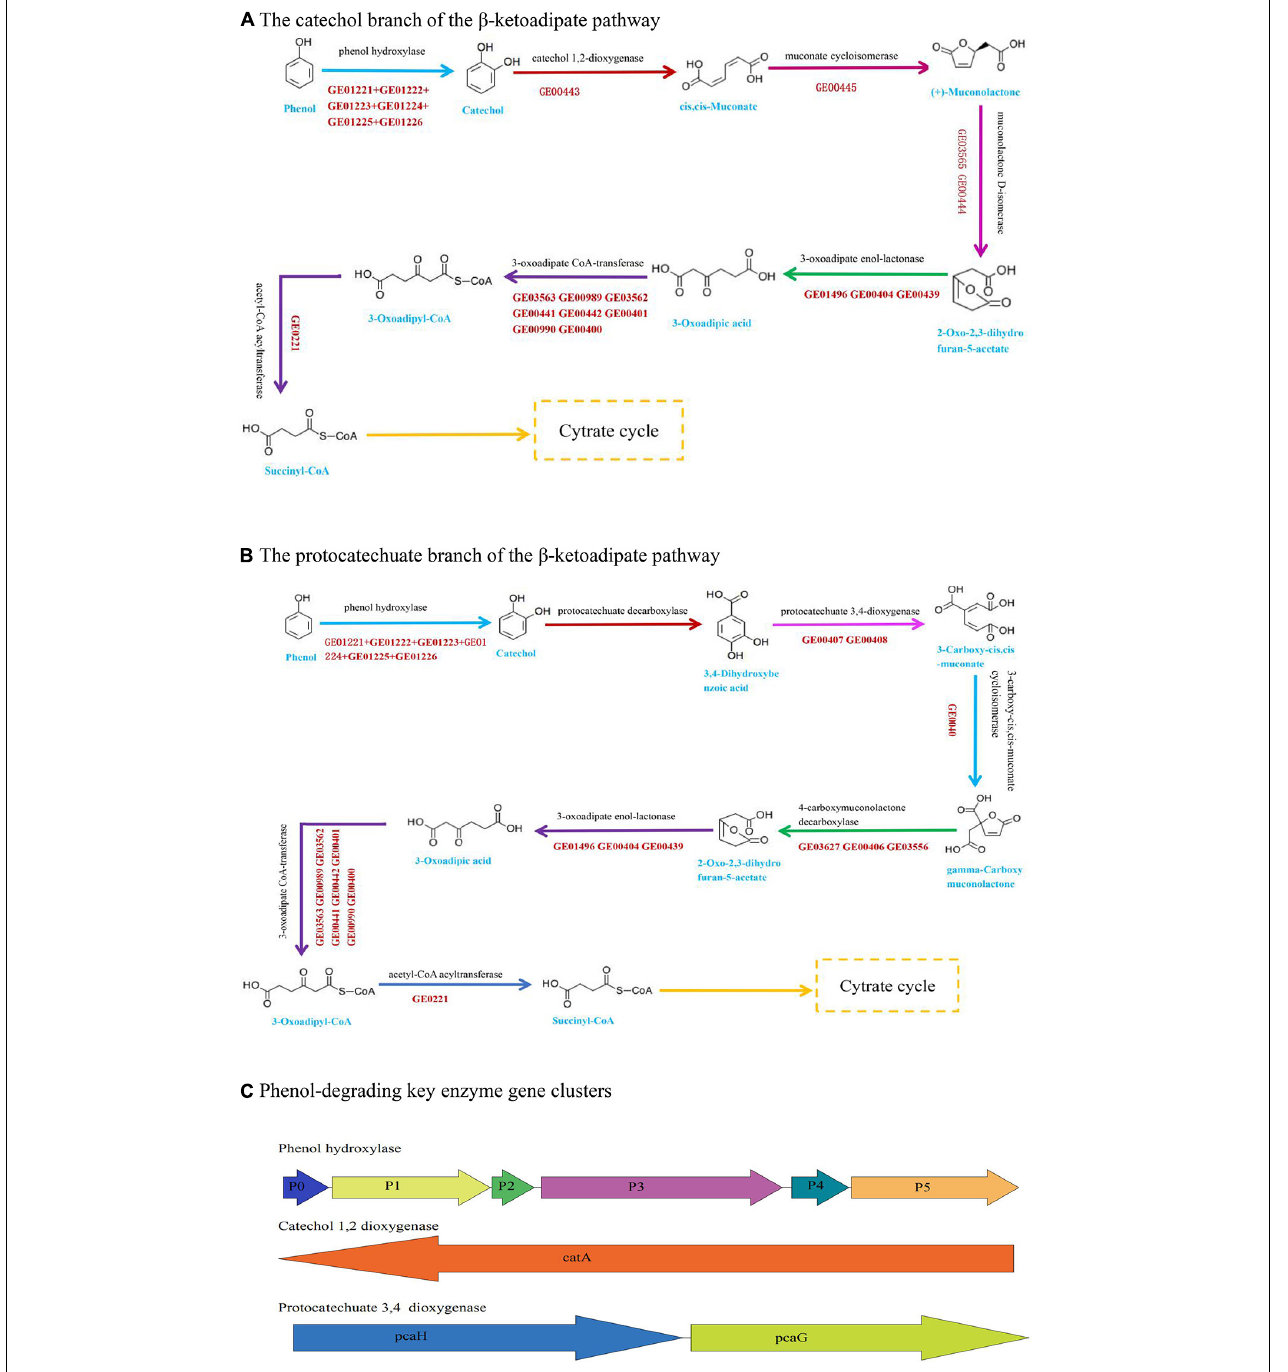
FIGURE 3 | Pathway and key enzyme gene clusters involved in phenol degradation based on genome data. (A) The catechol branch of the β -ketoadipate pathway in Acinetobacter sp. DW-1. (B) The protocatechuate branch of the β -ketoadipate pathway in Acinetobacter sp. DW-1. (C) Genomic organization of the key enzyme gene clusters in phenol